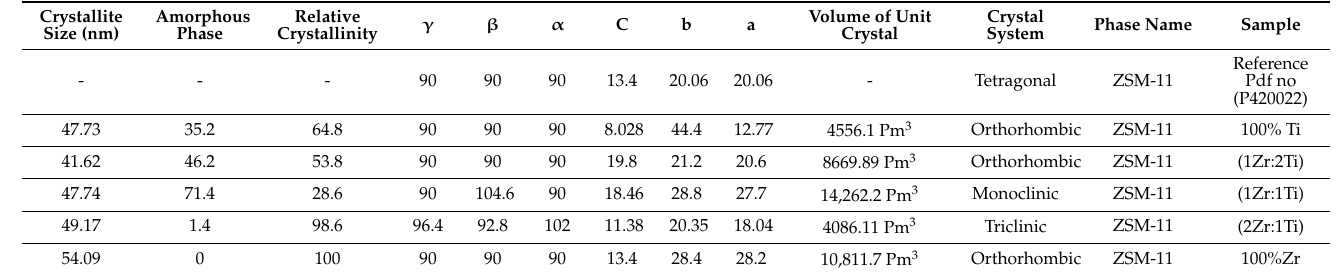
Table 1. Crystal lattice analysis of investigated samples.